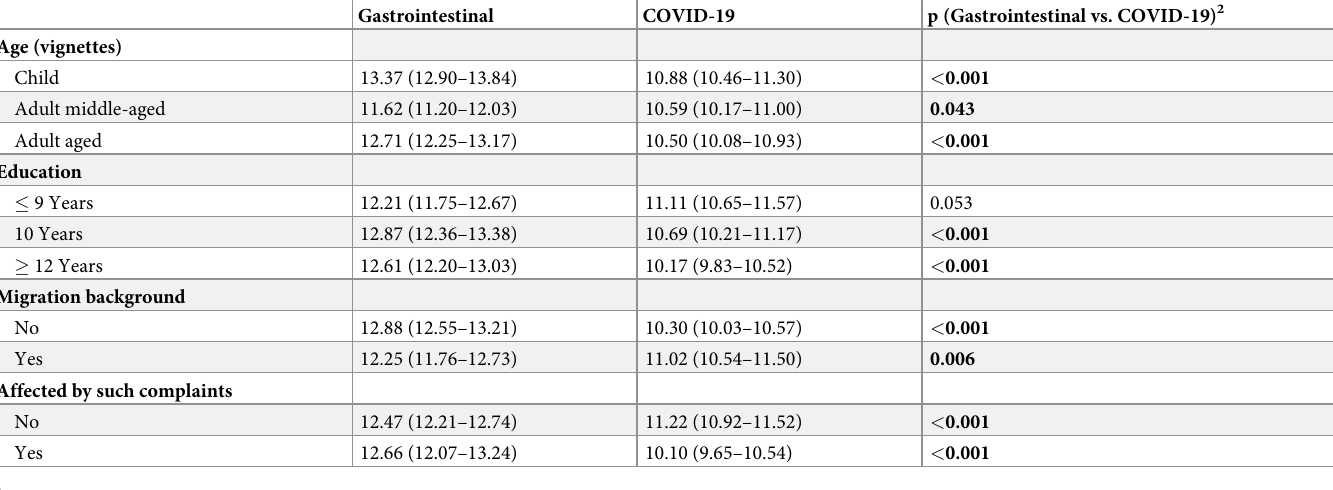
Table 4. Predicted values (95% CI) of perceptions of urgency of symptoms (N = 1,091) 1